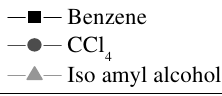
Figure 1. Variation of internal pressure ( π